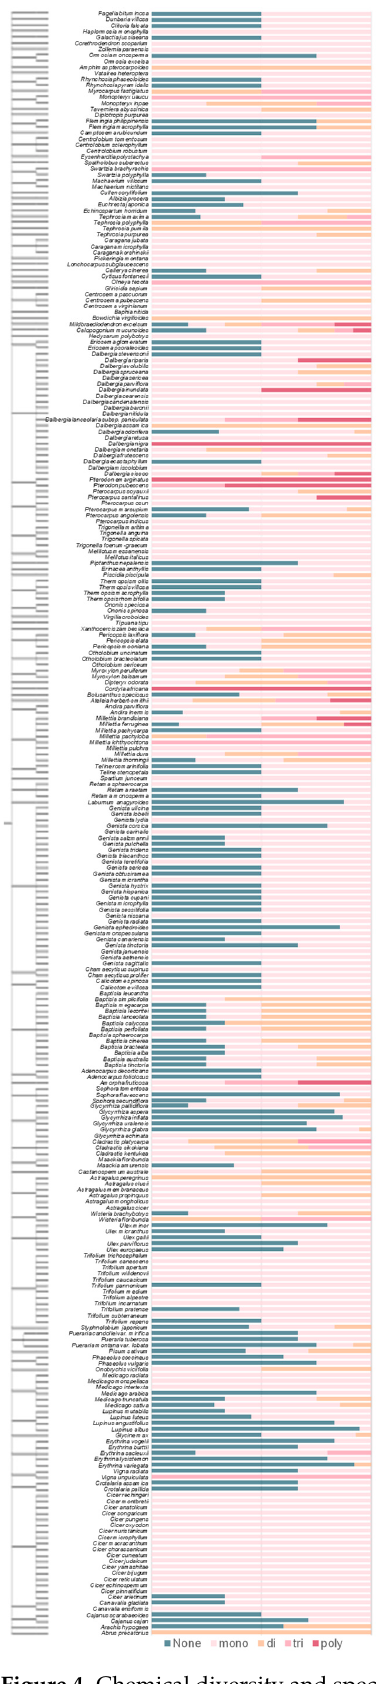
Figure 4. Chemical diversity and species specificity of methoxylated flavonoids in Fabaceae plants.